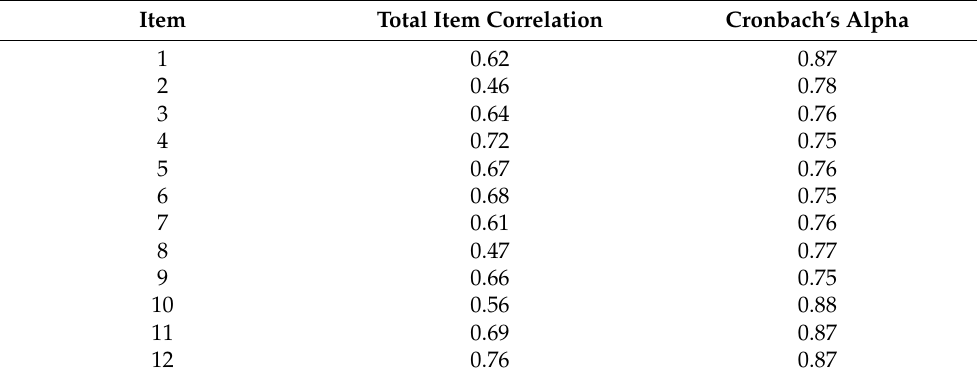
Table 1. Internal consistency of the Portuguese version of MISS. Item Total Item Correlation Cronbach’s Alpha 1